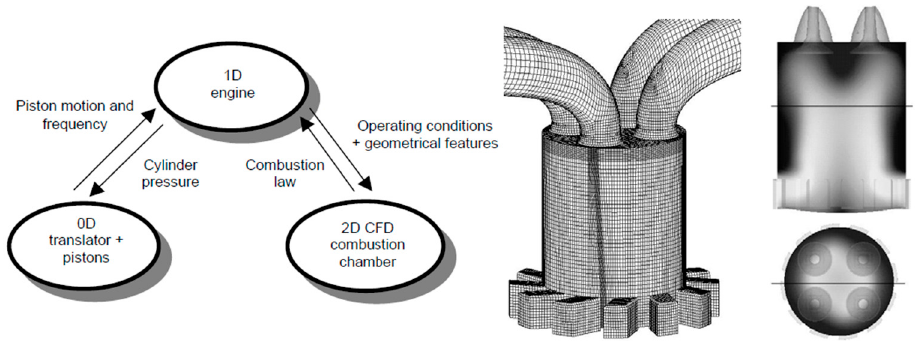
Figure 27. France IFP free-piston engine 0-3D modeling ideas and simulation model [69].